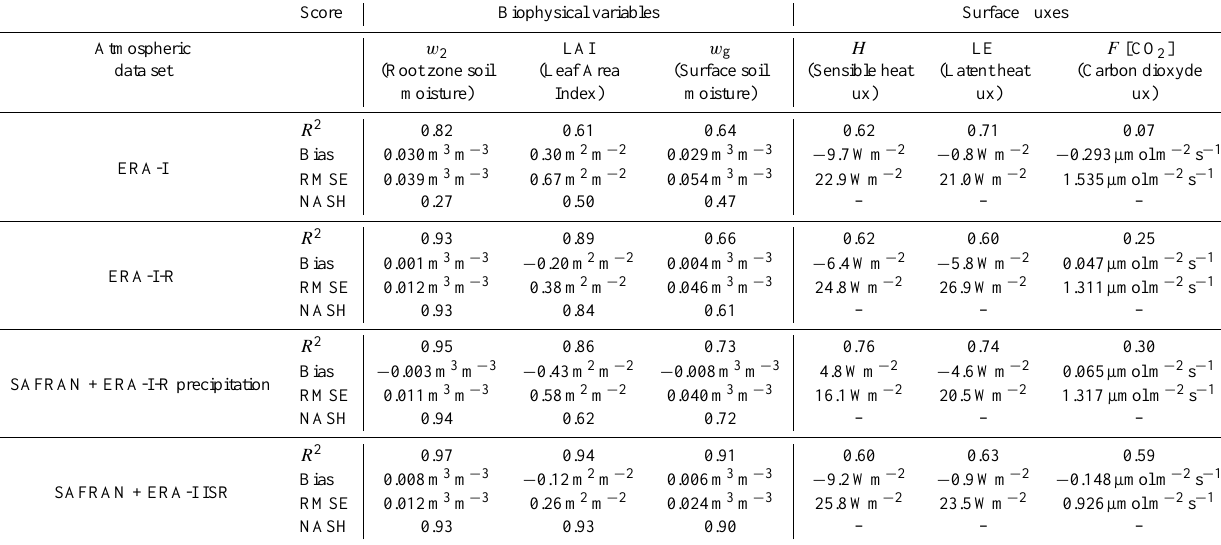
Table 7. Performance of the ISBA-A-gs model for the SMOSREX site over the 2001–2007 period with different atmospheric forcing data sets (ERA-I, ERA-I-R): mean bias (SAFRAN minus other data sets), RMSE, R 2 and NASH for various biophysical variables and fluxes obtained from the reference SAFRAN atmospheric forcing data on the SMOSREX